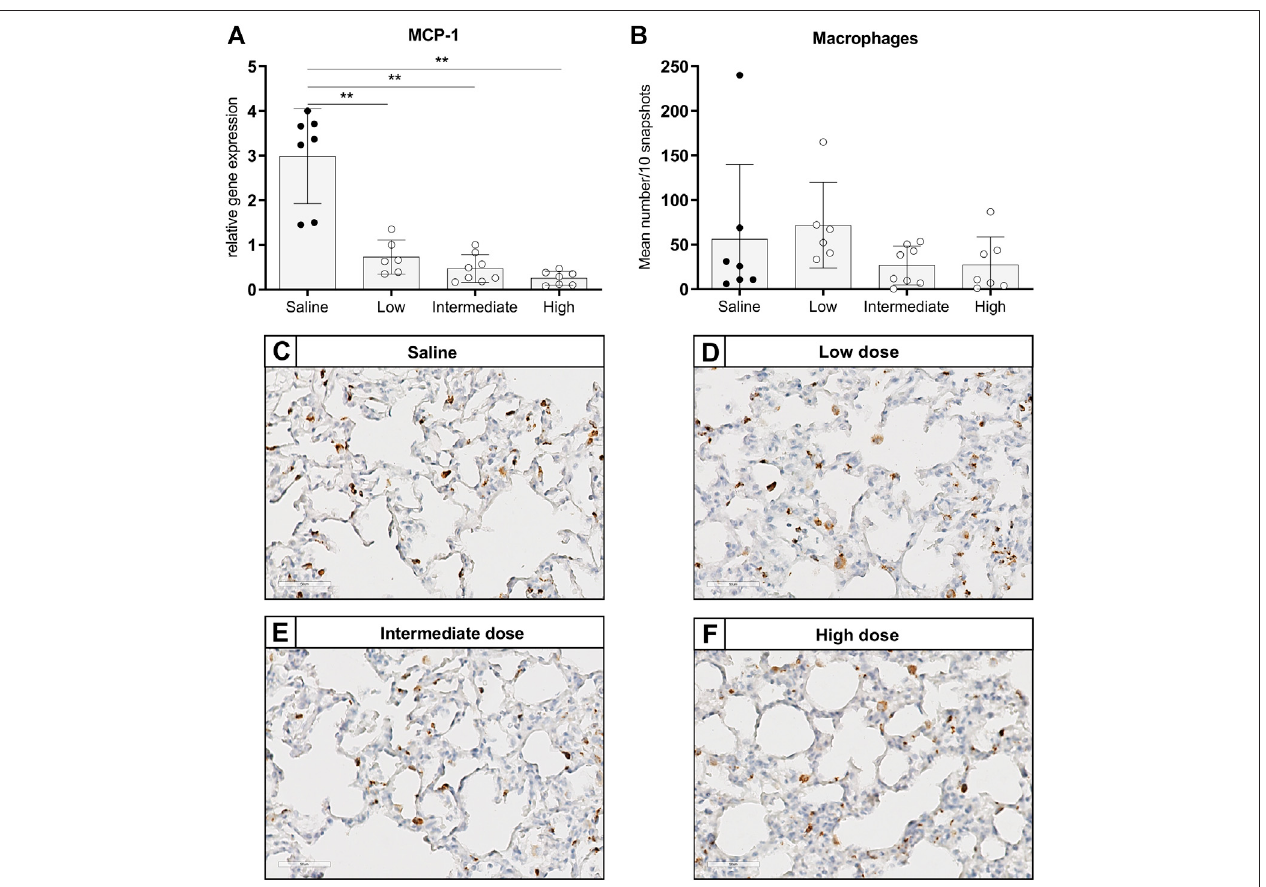
FIGURE 3 | Chemotaxis of macrophages and in fi ltration of macrophages in lung tissue. Brain death (BD) was induced in rats assigned to one of four experimental groups, etc. and 1 h after BD induction rats were treated intravenously with 1) 0.9% saline (control) 2) low dose methylprednisolone (5 mg/kg of bodyweight (BW), 3) intermediate dose methylprednisolone (12.5 mg/kg of BW) and 4) high dose methylprednisolone (22.5 mg/kg of BW). (A) mRNA gene expression levels of MCP-1, involved in chemo-attraction of macrophages. Data are shown as expressions relative to housekeeping gene β -actin. (B) Quanti fi cation of CD68-stained macrophages in lung tissue, presented as mean count per 10 random fi elds. (C – F) : Representative snapshots of lung slides stained for CD68. Values are presented as mean ± SD. ** p <